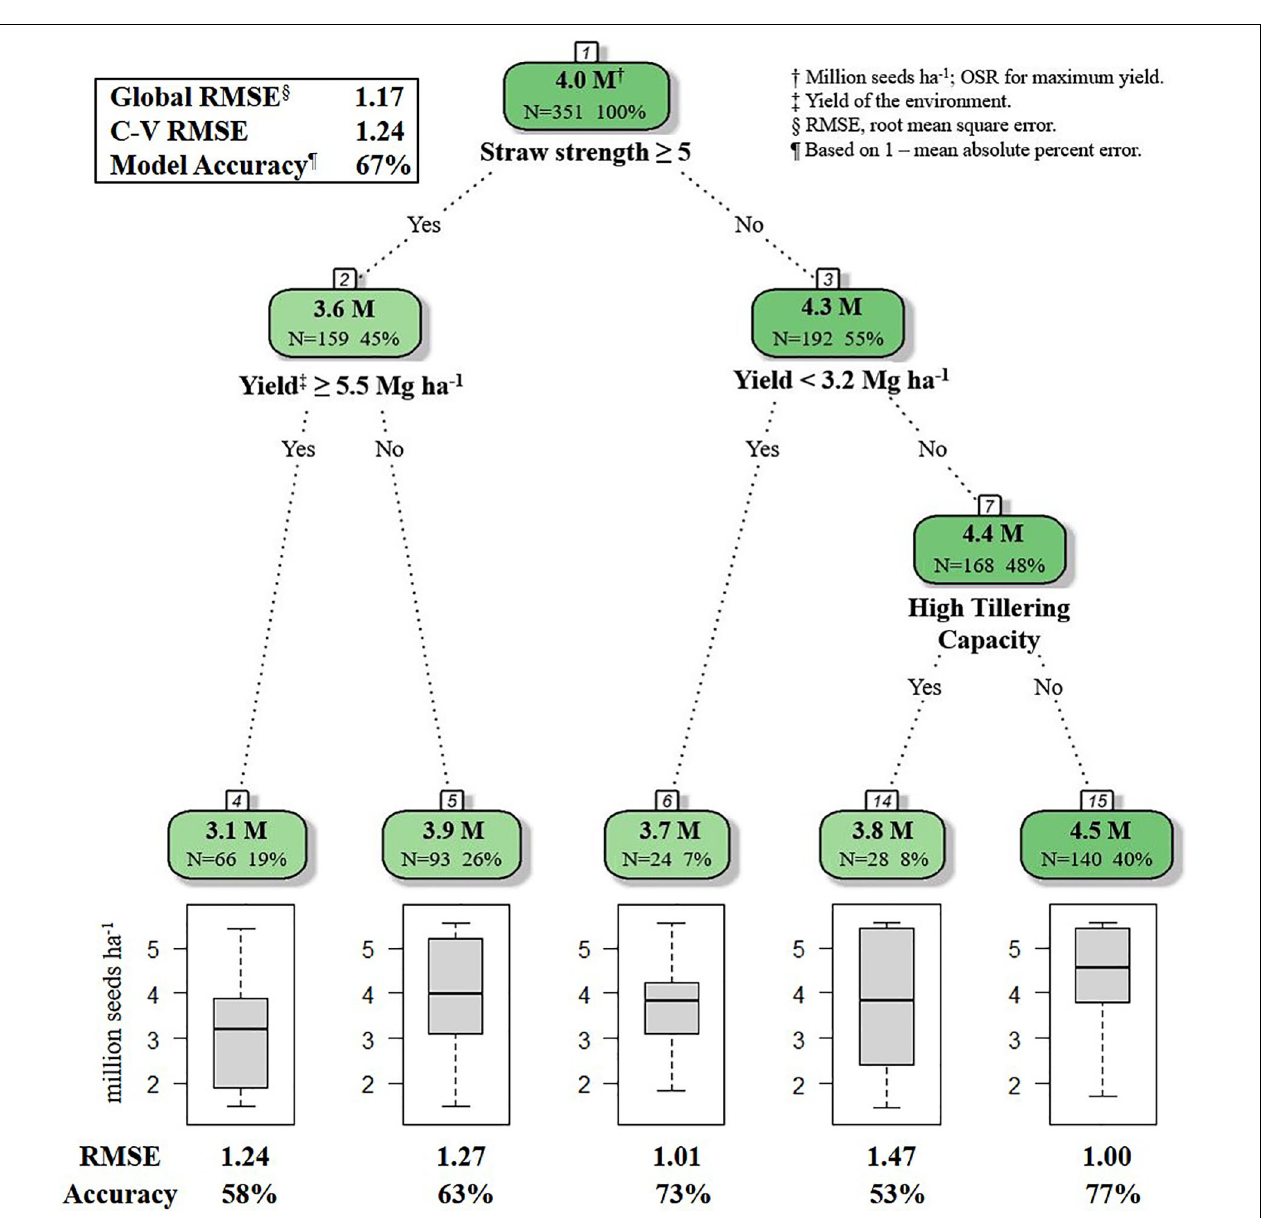
FIGURE 1 | R decision tree model for selecting optimal seeding rate for HRSW cultivars in differing environments in ND and MN ( n = 351). Straw strength rating (1–9; 1 is erect, 9 is lying flat) for varieties in HRSW variety trial publications from North Dakota State University Extension, 2018 and University of Minnesota, 2018. Tillering capacity determined from Z -score standardized values from tillering evaluations of HRSW cultivars at spaced plantings by Stanley (2019); where cultivar tillering capacity rating is: High ( Z > 0.67), Moderate (0.67 ≤ Z ≥ − 0.67), or Low ( Z < − 0.67). Number of samples and percent of whole dataset are reported for root, nodes and leaves. Model Accuracy = 1–mean absolute percent